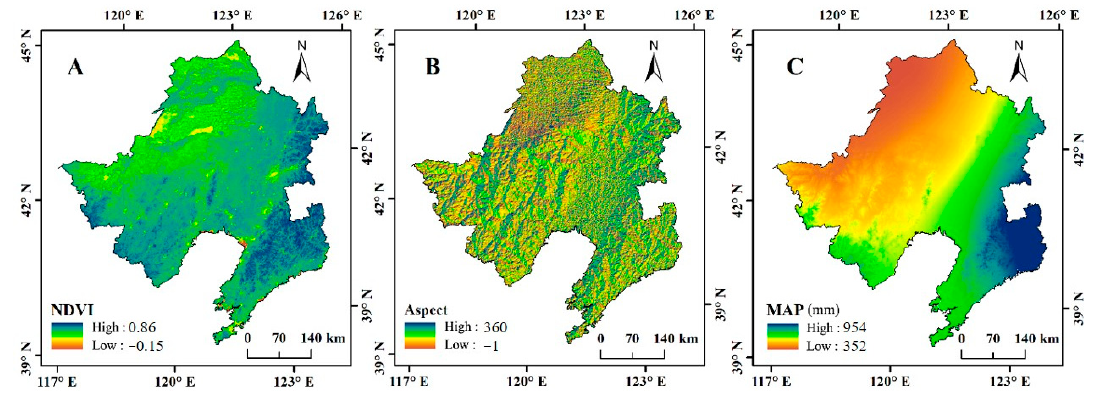
Figure 2. Three examples of environmental variates to predict wetland soil organic carbon concentration (SOCc): ( A ) normalized difference vegetation index (NDVI), ( B ) aspect (the value of − 1 means flat), and ( C ) mean annual precipitation (MAP).